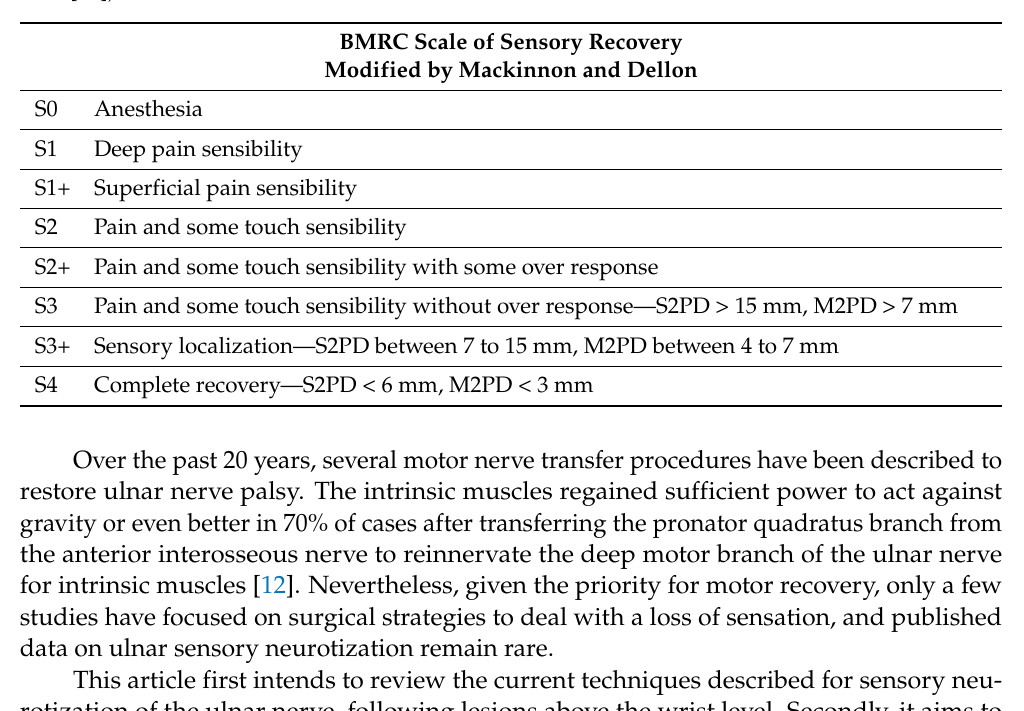
Table 1. Classification of sensory recovery according to the Nerve injuries committee of the British Medical Research Council (BMRC), modified by Mackinnon and Dellon (adapted from Wang et al., 2013